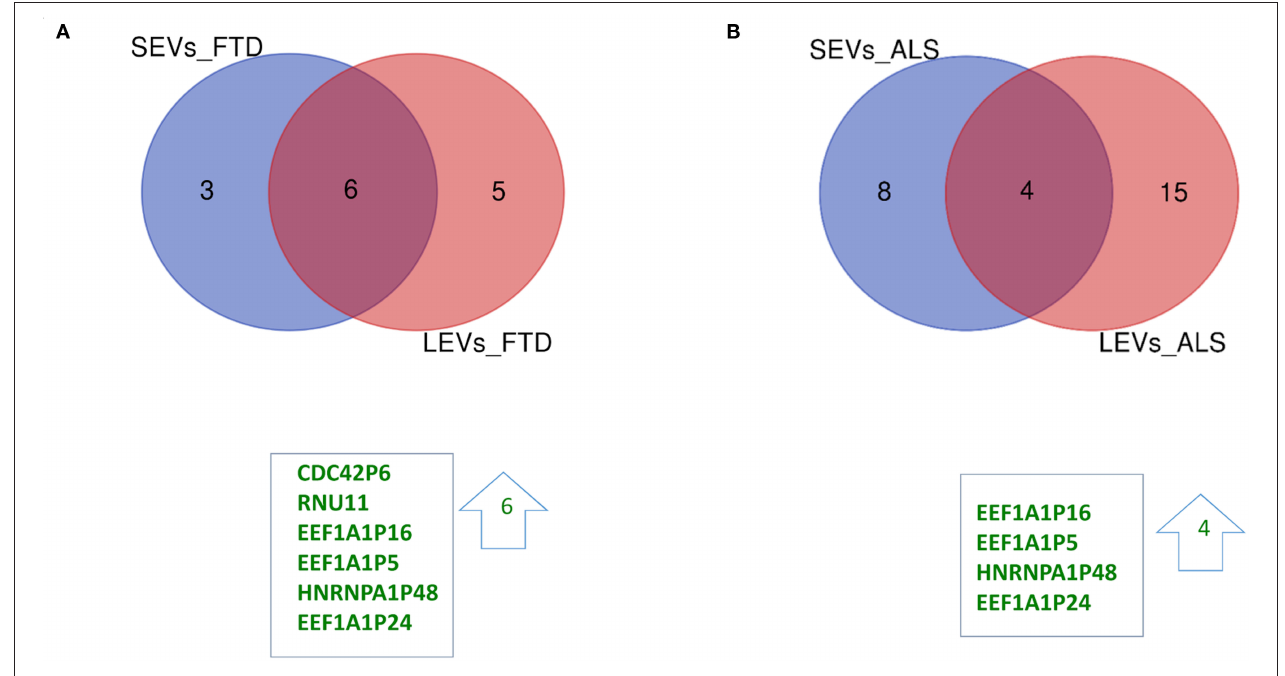
FIGURE 2 | Common packaging of deregulated long non-coding RNAs (lncRNAs) and pseudogenes into SEVs and LEVs from FTD and ALS patients. (A) For FTD, of the 9 lncRNAs in SEVs and 11 in LEVs, 6 were in common (all upregulated, green). (B) For ALS, of the 12 lncRNA in SEVs and 19 in LEVs, 4 were in common (all upregulated, green). Differential lncRNA expression analysis was carried out using DESeq2 (log2FC > 1, p < 0.05).